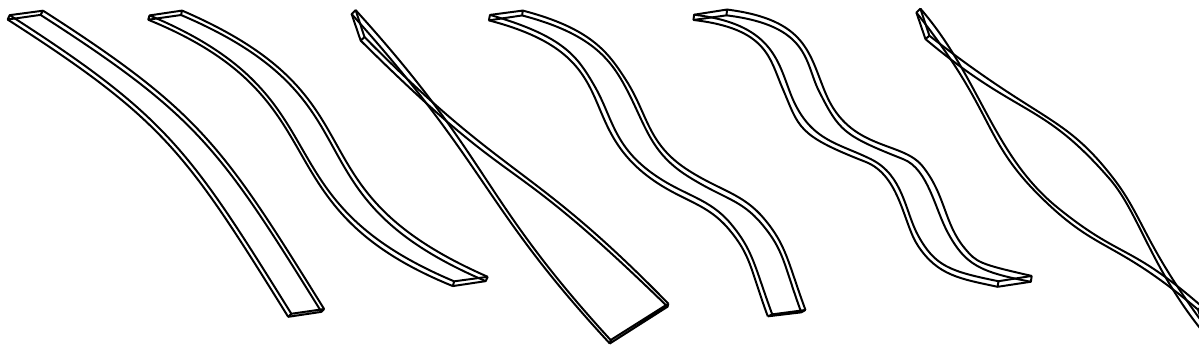
Fig. 3. Shapes of first six eigen modes, third and sixth mode are torsion (twisting) ones rest are bending (flex) modes. Depicted order is valid for sumberged steel